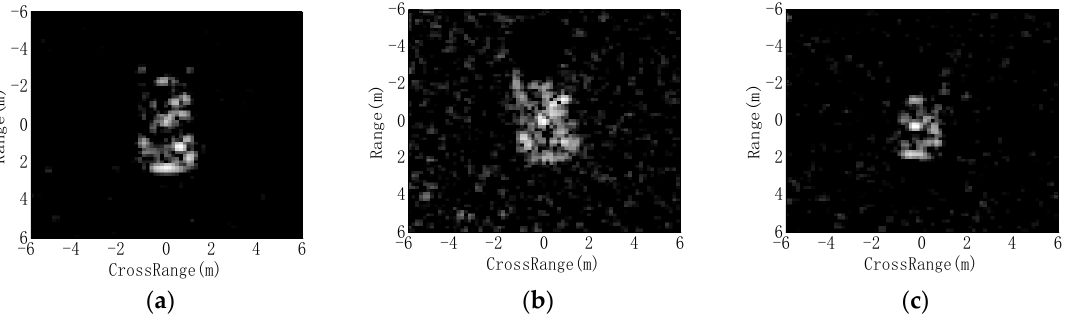
Figure 10. SAR images from depression angles of: ( a ) 17 ◦ ; ( b ) 30 ◦ ; ( c ) 45 ◦ . Table 8. Template and test sets with large depression angle variation. Depr.